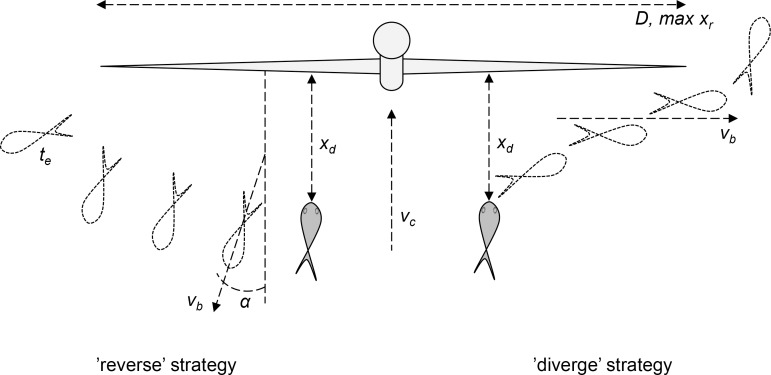
Representation of the two modeled avoidance strategies for a fish approaching a turbine.In these simplified models of fish avoidance D denotes the rotor diameter, defining the maximum swimming path of avoiding fish. x
r is the random position on the rotor disc where the fish appears when approaching the turbine and x
d is the distance at which the fish detects the turbine. x
r is the required swimming path, defining the distance that the fish has to swim to reach safety. v
b denotes the fish burst speed and α is the angle that reversing fish take in order to keep the turbine in the rear view while swimming away. t
e is the time to exhaustion for reversing fish, which defines the time in which the fish has to cover the required swimming path to safety (outside the rotor swept disc).